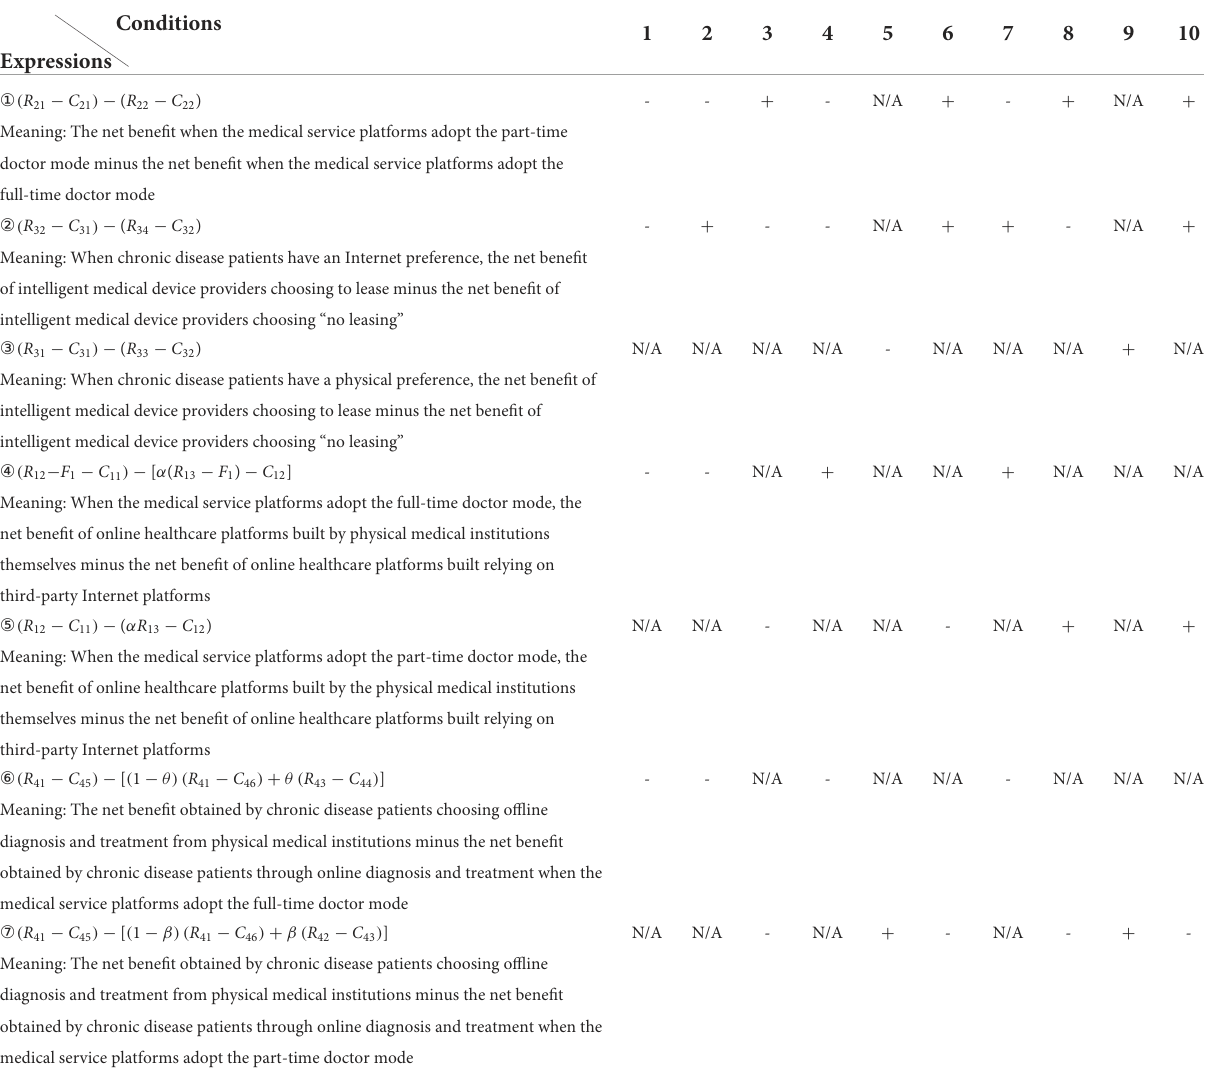
TABLE 4 The compatibility among conditions 1–10.